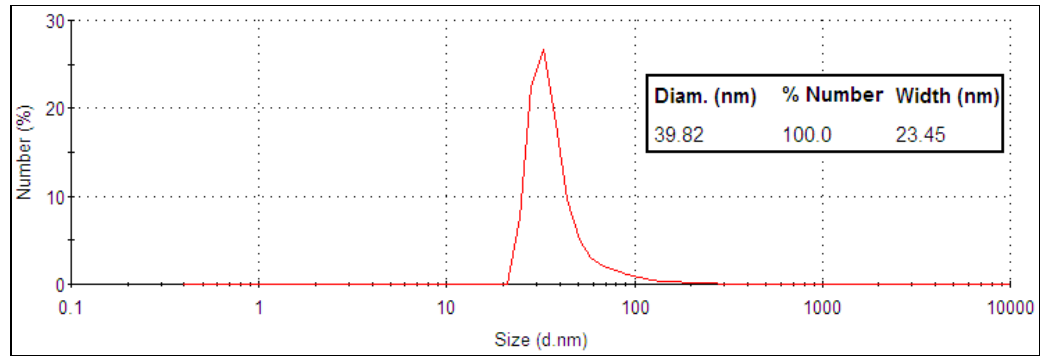
Figure 2. DLS size distribution data of 40 nm gold